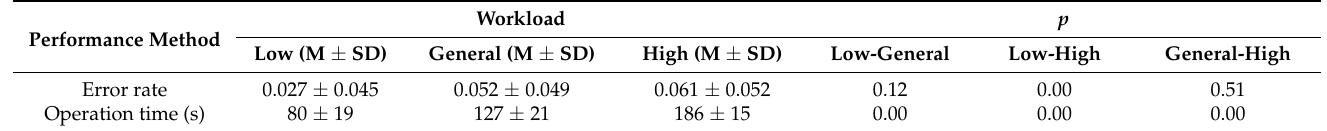
Table 5. The t -test of performance date between different workloads.